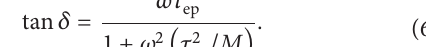
Figure 2: tan 𝛿 versus 𝜔 curve for the three systems (i.e., NaClO 4 , NaI, and NaSCN containing systems) having 50%